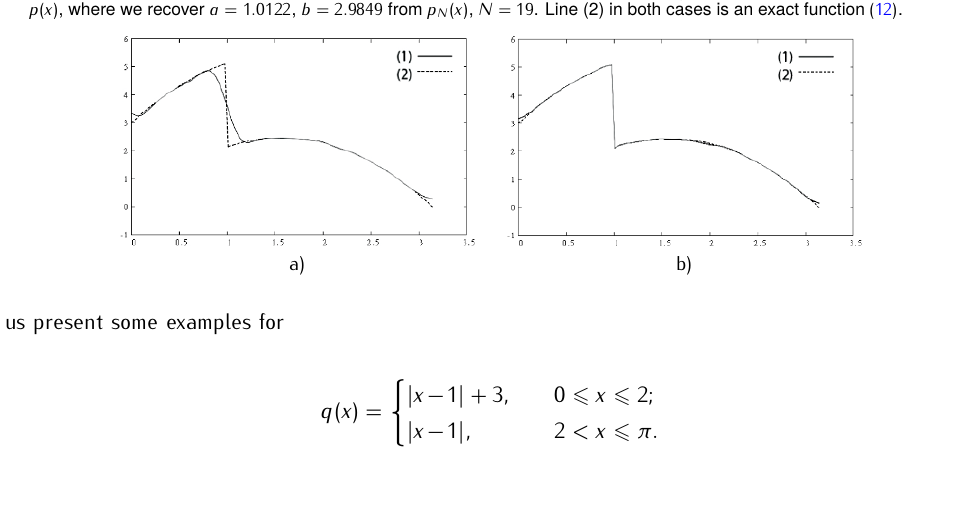
)R π q ( x ) dx , b) using the adapted reference potential 0